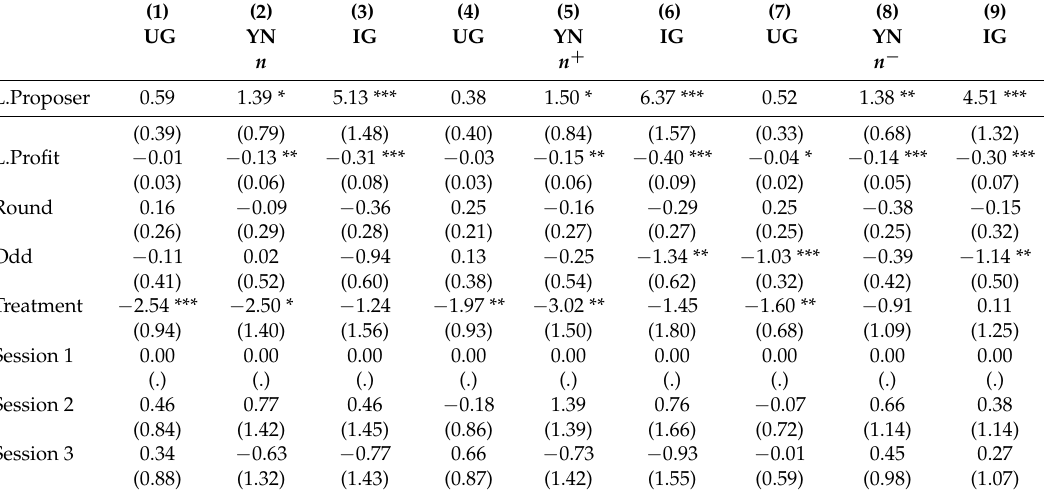
Table A1. Choice dynamic by Game (1)-controlling for single